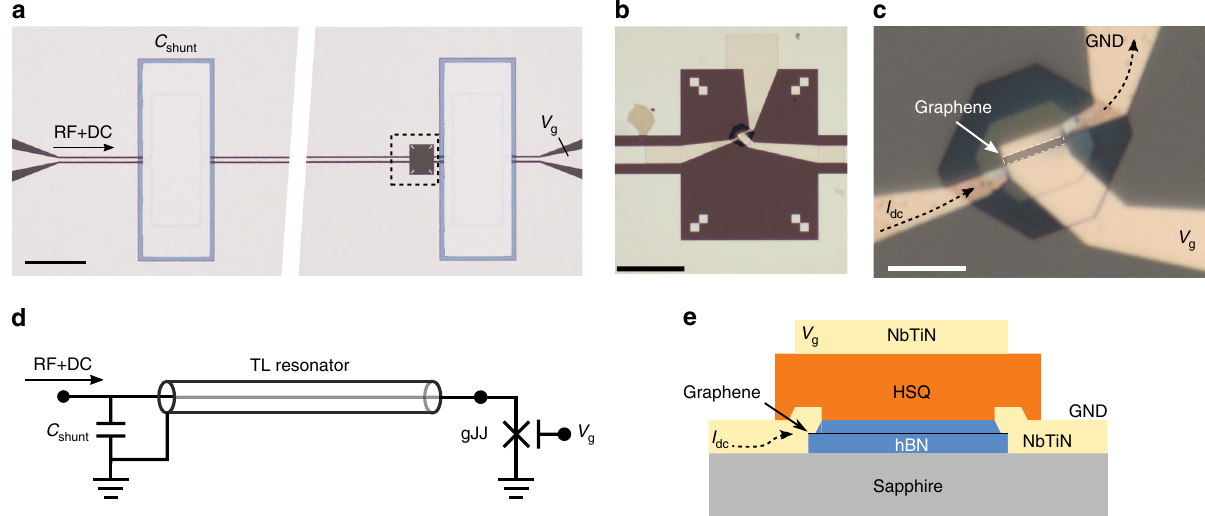
Fig. 1 A gate tunable microwave cavity based on an encapsulated graphene Josephson junction. a Optical micrograph of the microwave cavity before placing the BN/G/BN stack. Bright areas are MoRe, dark areas are sapphire substrate. Grey area around the parallel plate capacitors is the Si 3 N 4 shunt dielectric. Scale bar 200 μ m. b Optical micrograph of the gJJ. The cavity center line and the ground plane are connected through the gJJ and NbTiN leads. The gate line (right) extends over the entire junction. Scale bar 40 μ m. c Close-up of b with the graphene channel indicated. Dark areas are HSQ for gate insulation. Scale bar 5 μ m. d Sketch of the device circuit. The input signals are fi ltered and merged using a bias tee before being fed on to the feedline (see Methods section and Supplementary Fig. 1). e Schematic cross-section of the gJJ with top-gate, not to